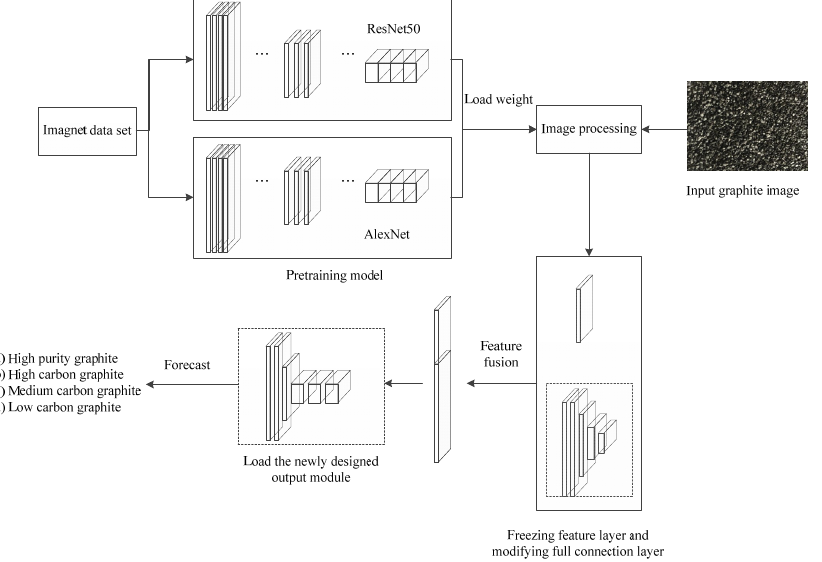
Figure 10. Convolution neural network model with multi-model weighted fusion mechanism com- bined with transfer learning.